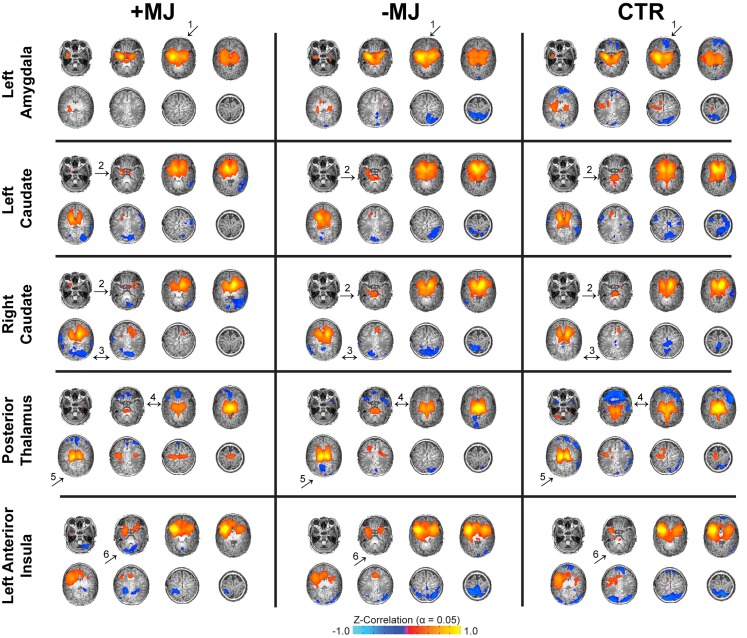
Neonatal functional connectivity and prenatal marijuana exposure. Functional connectivity for different seed regions (top to bottom) and infant groups (left to right): marijuana positive (+MJ) with or without in utero exposure to alcohol, nicotine, SSRIs, and opiates; infants with in utero exposure to some combination of the aforesaid drugs minus marijuana (−MJ); and age-matched drug-free controls (CTR). Data threshold set using the combined approach: α = 0.05: voxel-wise p ≤ 0.01, cluster size = 32 voxels. Pseudo-coloring (see color bar at bottom) is based on Fisher’s Z-transformation of the temporal correlation between each voxel and the seed region. Data visualized in the axial view on a subset of high-resolution T1-weighted reference images.